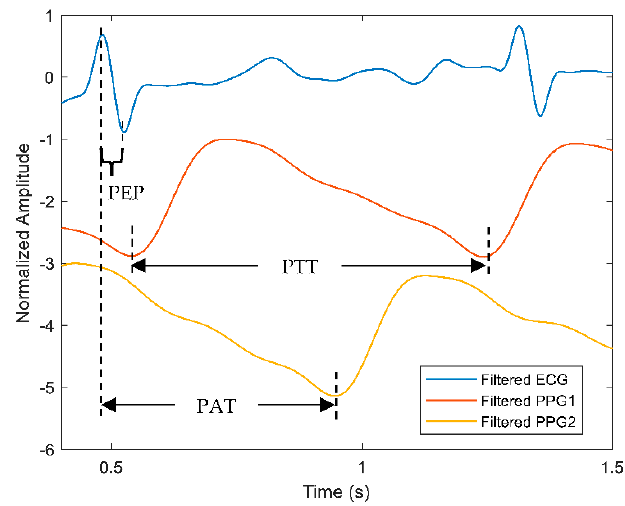
Figure 8. A comparison of PEP, PAT and PTT calculation measured from the ECG and PPG signals. Blue line represents the ECG signal while red and orange lines describe the filtered PPG signals from two sources: the first and second PPG signals are labelled as PPG1 and PPG2, respectively.